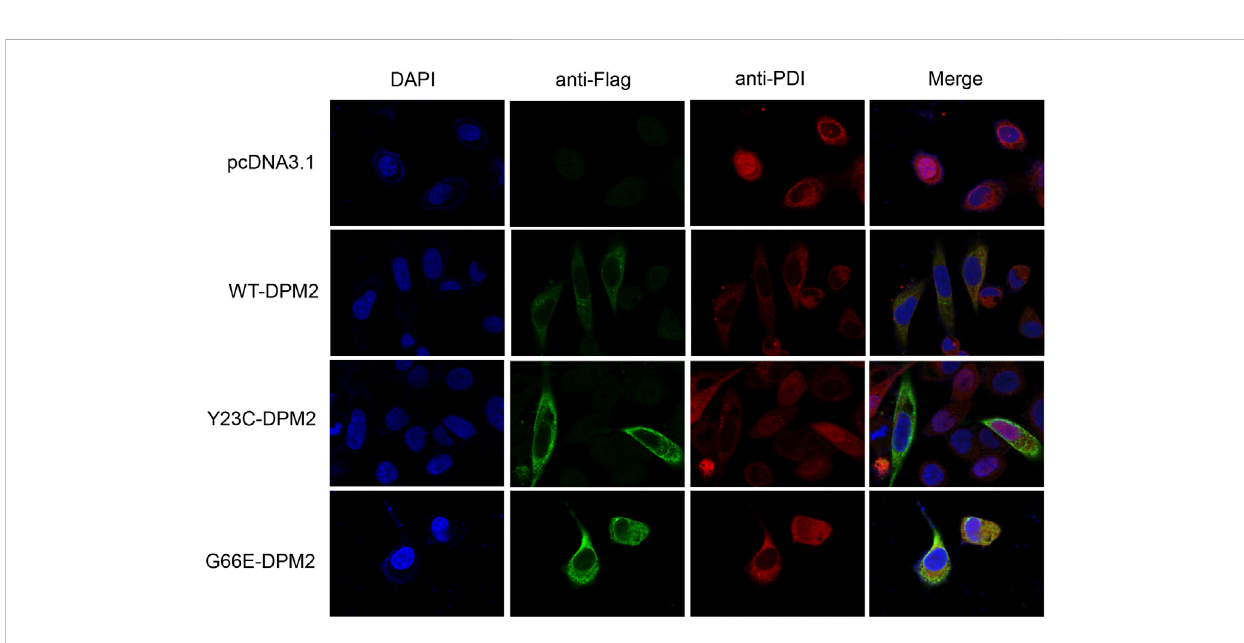
FIGURE 3 DPM2 protein expression and subcellular localization in HCT116